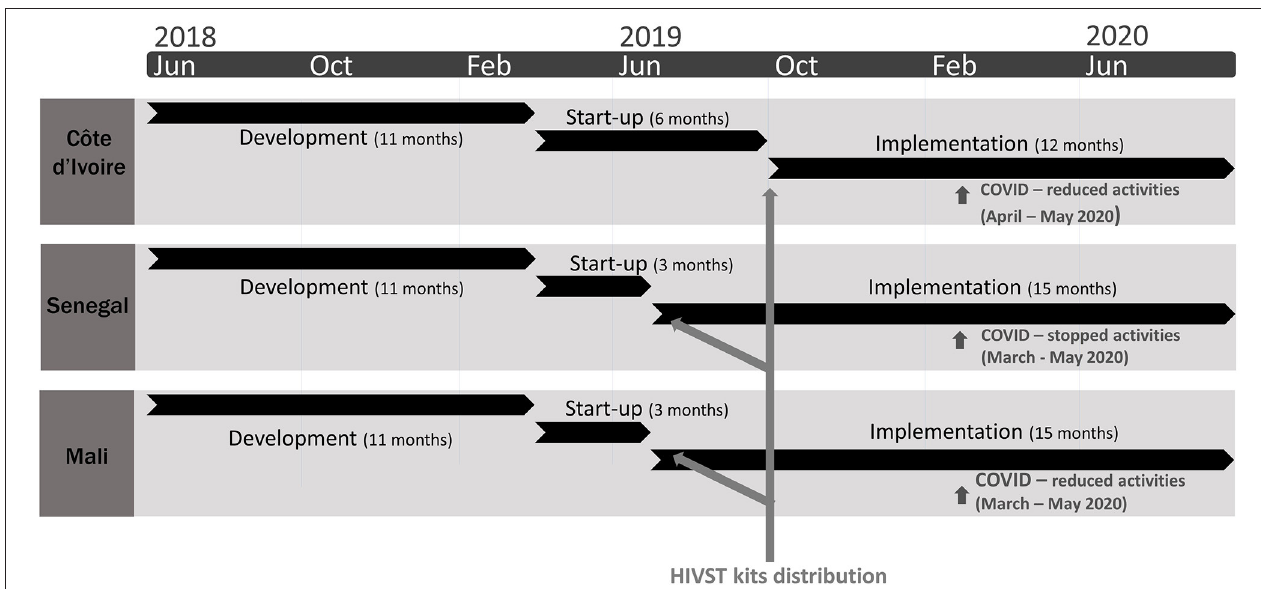
FIGURE 1 | Description of the ATLAS project’s three HIV self-testing (HIVST) deployment phases in Côte d’Ivoire, Senegal, and Mali over 2018–2020.